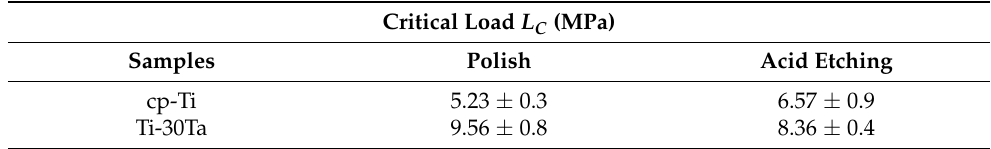
Table 7. Critical load Lc obtained via scratch